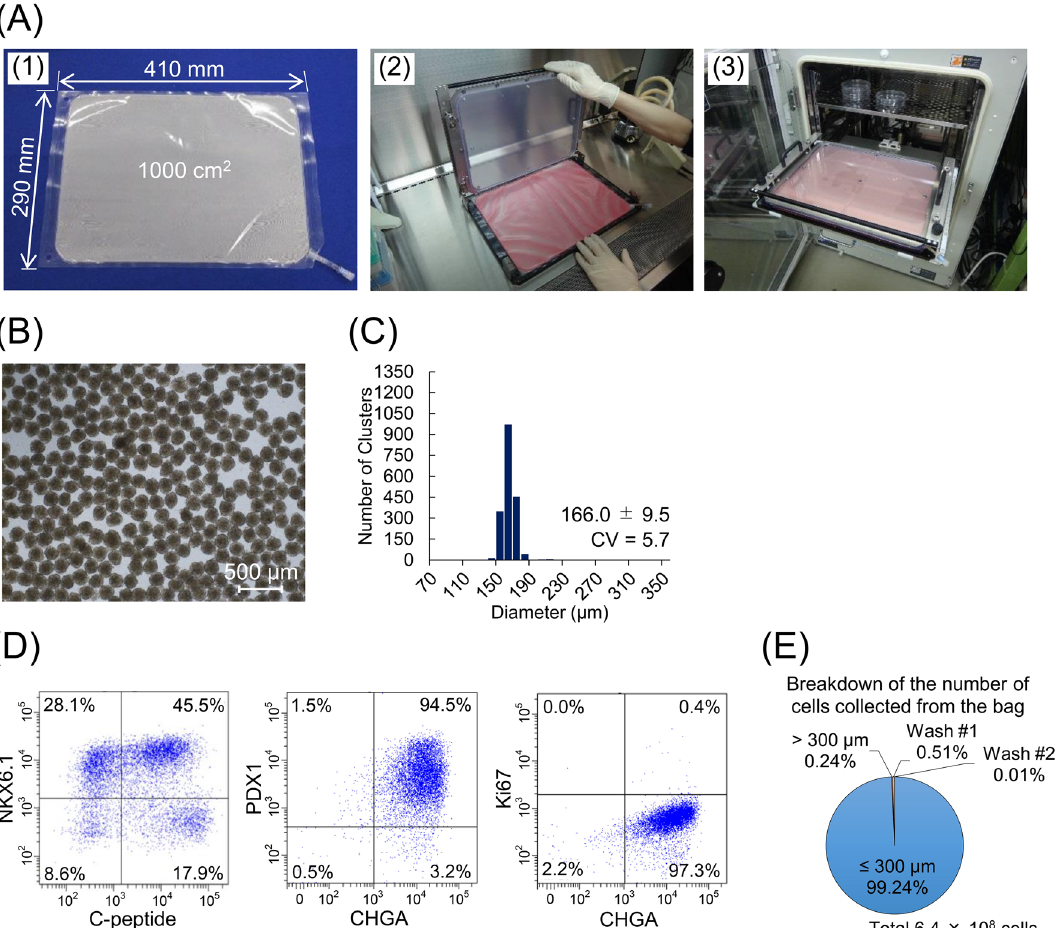
Figure 4. Large-scale production of the uniform-sized induced pluripotent stem cell-derived pancreatic islet cell (iPIC) clusters. ( A ) The design of a large-scale microwell bag and jig. (A-1) The appearance of a large-scale microwell bag. The bag was made of gas-permeable film with a port at one corner. The culturing area is 1000 cm 2 . (A-2) The appearance of the jig with an open cover during attachment of the large-scale microwell bag. (A-3) Placing the jig in the incubator. The shelf in the incubator has been modified for horizontal removal of the jig–bag assembly. ( B ) A representative phase-contrast image of the iPIC clusters after harvesting. After thawing, the iPICs were cultured for 4 days to form a cluster in the large-scale bag. Scale bar = 500 μm. ( C ) Distribution of iPIC cluster size after 4-day culture in the large-scale bag analyzed using phase-contrast images of the clusters (mean ± standard deviation). In total, 1800 clusters were used for the measurement. ( D ) Representative dot plots of flow cytometry analyses for pancreatic endocrine cell makers and a proliferating cell marker. ( E ) Breakdown of the number of cells collected from the bag. Clusters larger than 300 μm in diameter were separated using a cell strainer. After harvesting, the clusters remaining in the bag were washed twice with PBS and collected (Wash #1 and